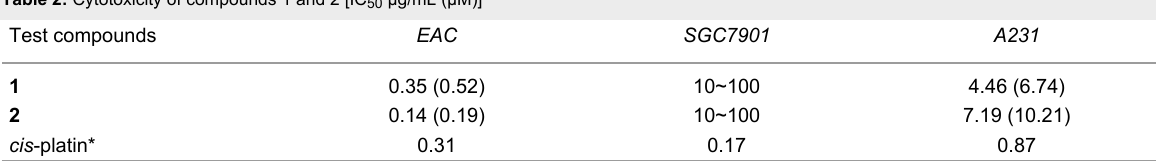
Table 2: Cytotoxicity of compounds 1 and 2 [IC 50 μg/mL